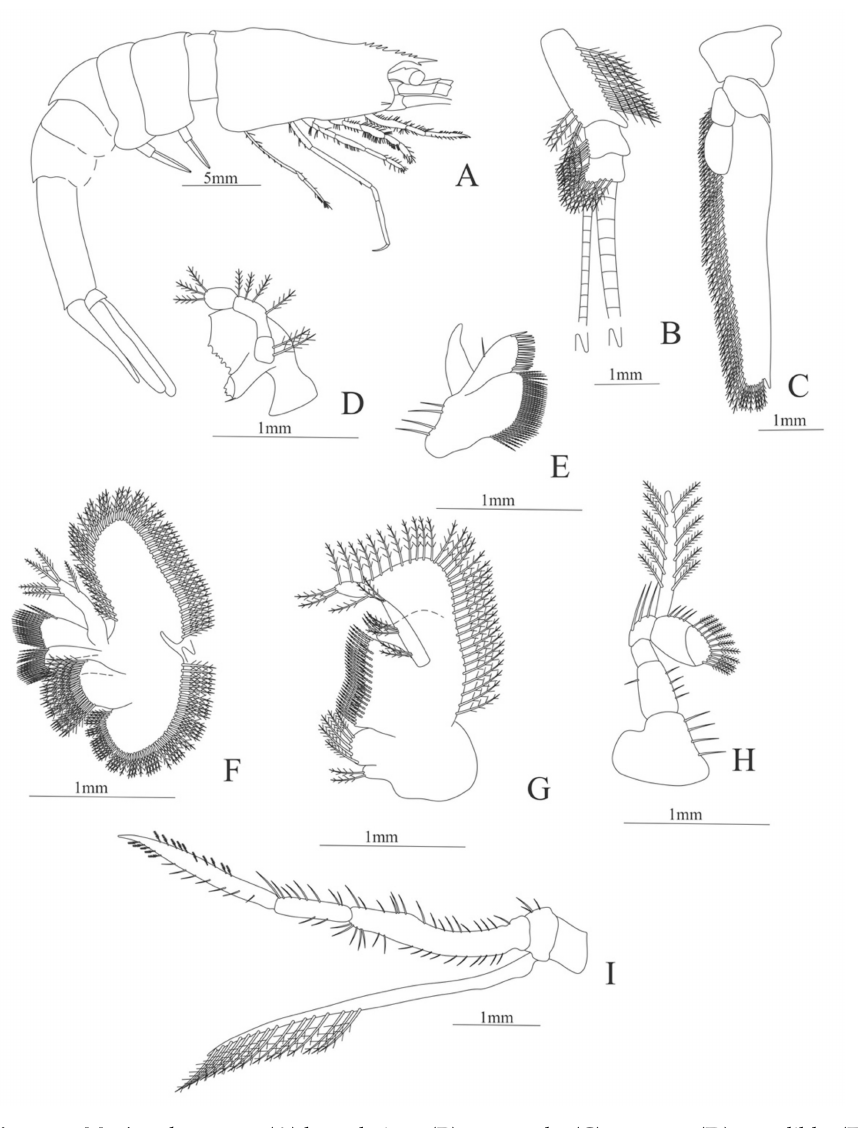
Figure 5. Meningodora vesca : ( A ) lateral view; ( B ) antennule; ( C ) antenna; ( D ) mandible; ( E ) maxillule; ( F ) maxilla; ( G ) first maxilliped; ( H ) second maxilliped; ( I ) third